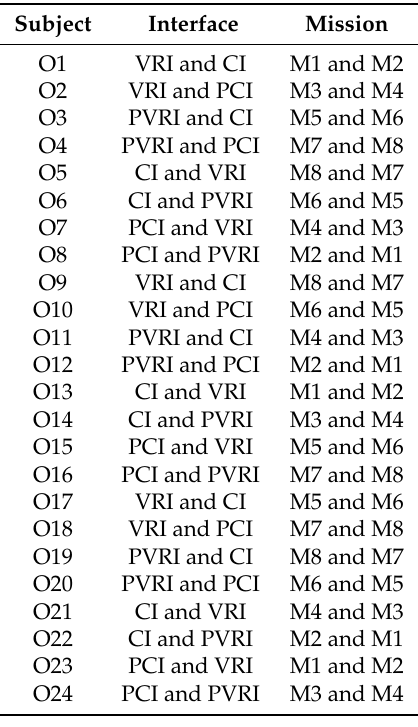
Table 5. Design of